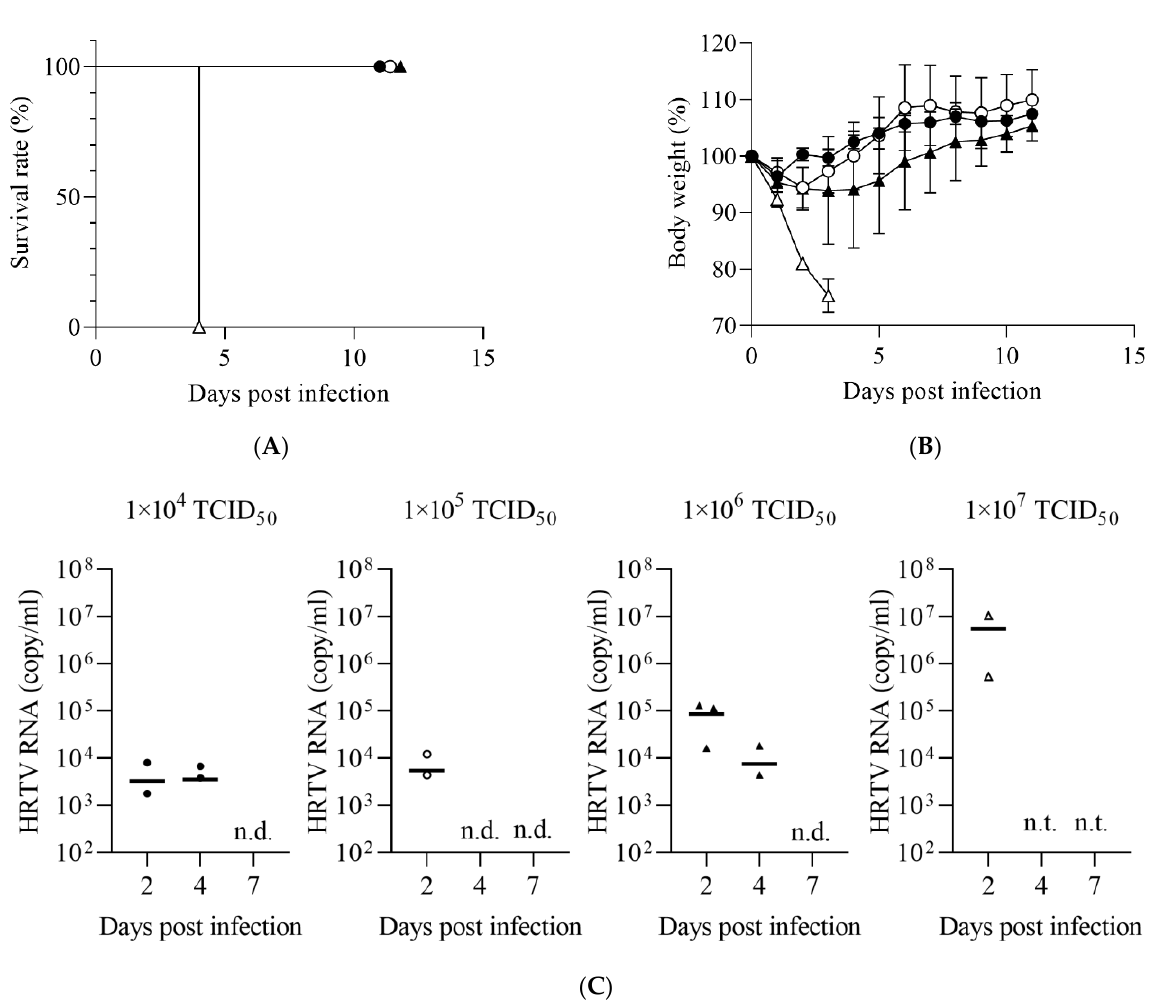
Figure 2. IFNAR −/− mice were infected intraperitoneally with 1 × 10 4 , 1 × 10 5 , 1 × 10 6 , and 1 × 10 7 TCID 50 of HRTV, which are indicated by the closed circles, open circles, closed triangles, and open triangles, respectively. Each group consisted of three mice, except for the 1 × 10 7 TCID 50 -HRTV-infected mice group, in which two mice were used. ( A ) Survival rate of infected IFNAR −/− mice. ( B ) Sequential body weight change of each group of IFNAR −/− mice. Relative weights were calculated and are shown as means with standard deviations. ( C ) The copy numbers of HRTV RNA in blood samples collected from infected IFNAR −/− mice on days 2, 4, and 7 postinfection. n.d.: not deter- mined. n.t.: not tested.